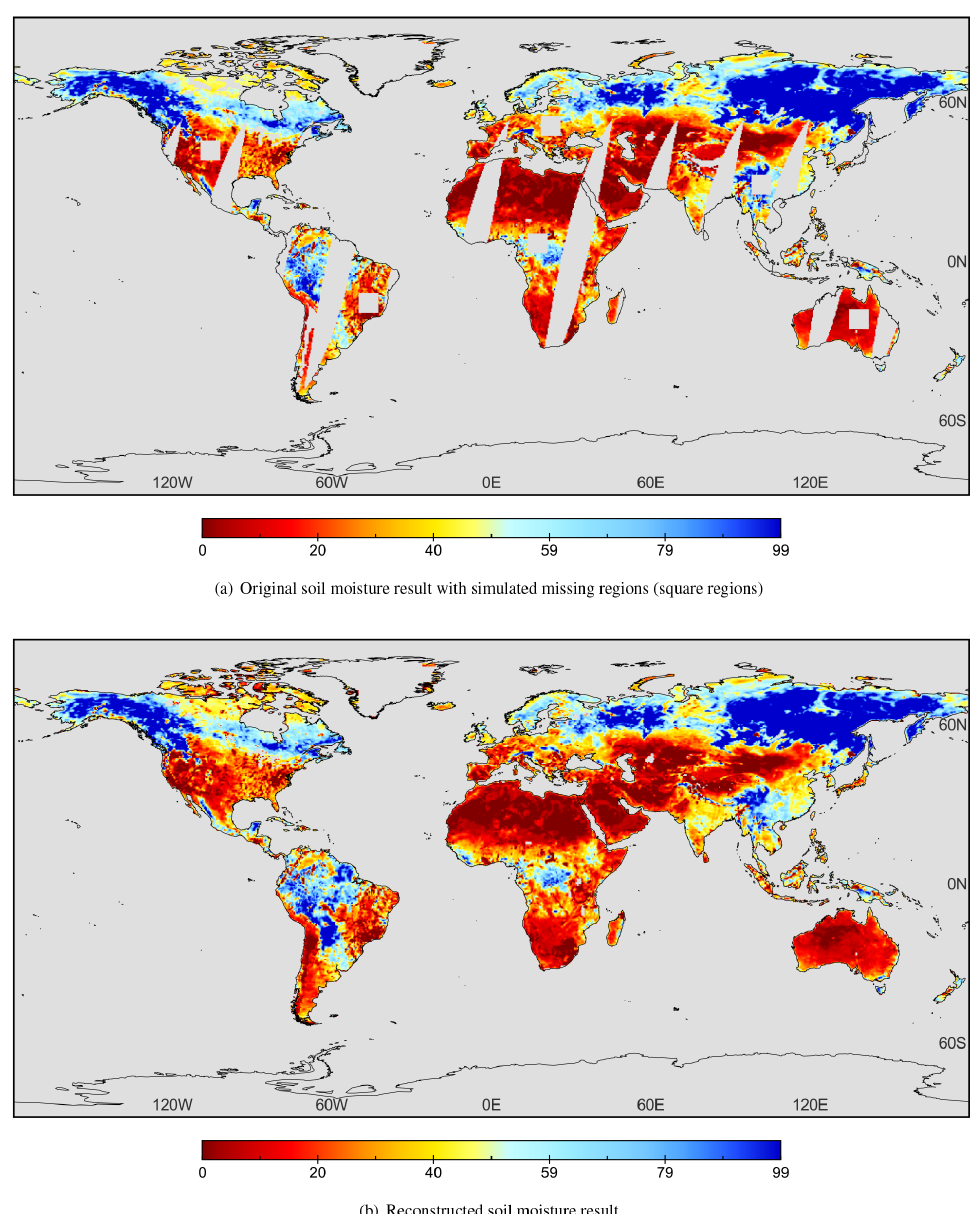
Figure 9. Original and reconstructed results with simulated missing regions in 25 July 2019.